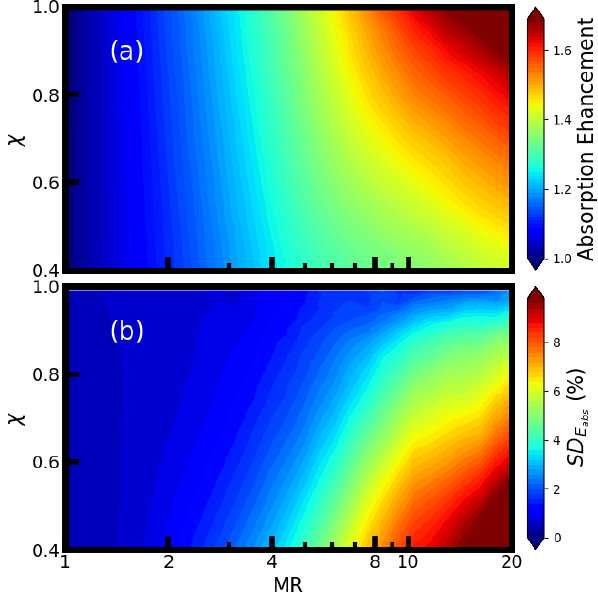
Figure 7. The calculated (a) mean E abs values and (b) standard deviations of the E abs values for different MR and χ